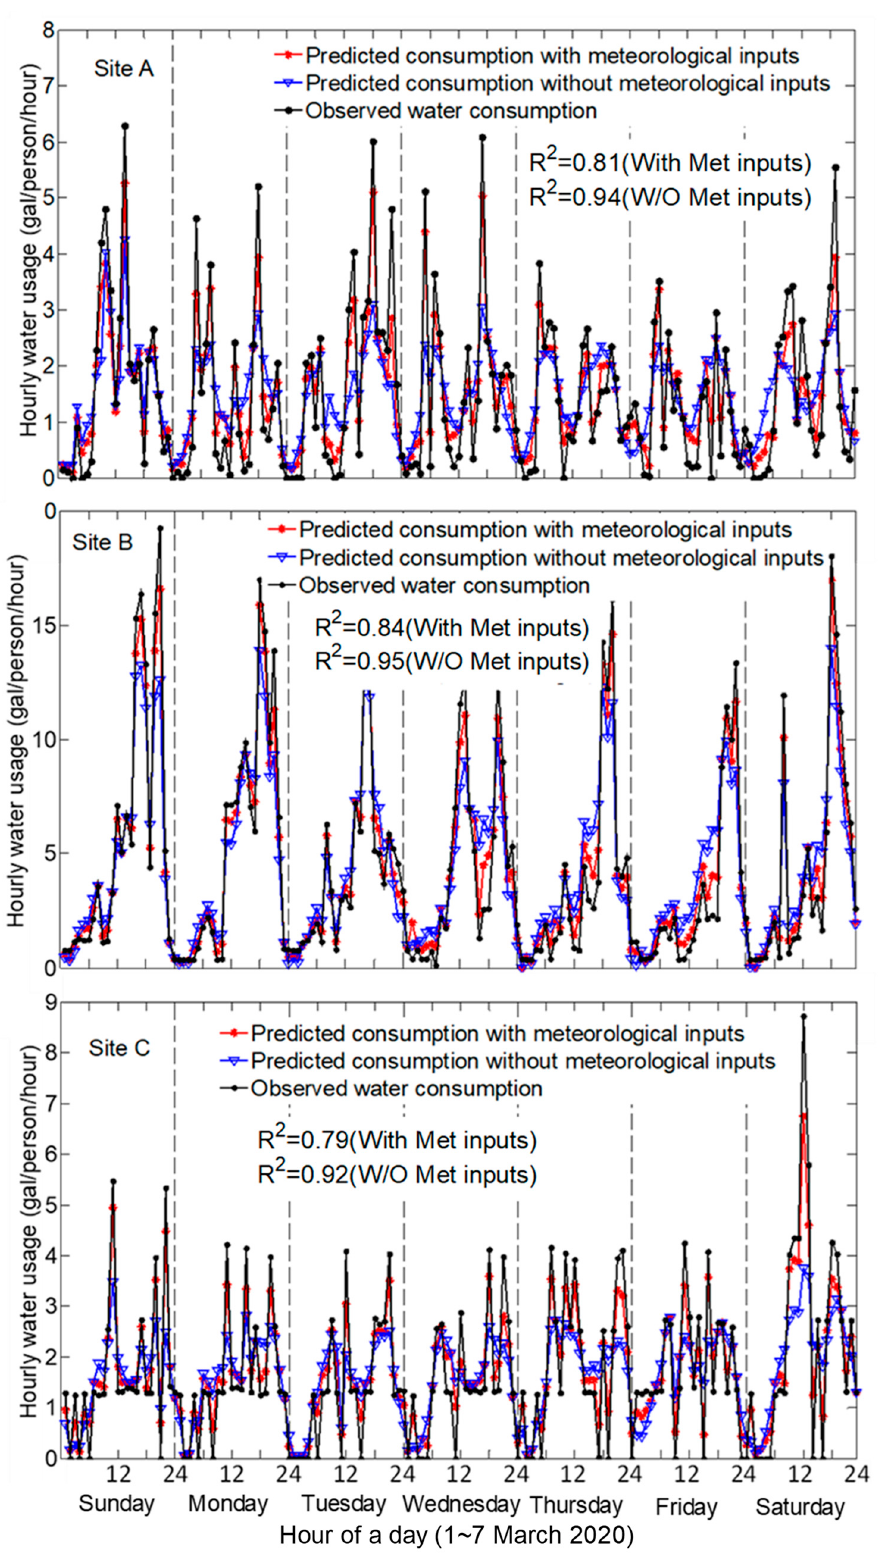
Figure 9. Illustration of validation of the hourly water usage model for a data trace during the first week of March 2020 (note: the indicated R 2 values are for the shown data trace). The ARMA model accounts for the month, week and day, hourly temperature, and total hourly rainfall input. Note: Training for hourly ARMA models for Sites A – C data were for the period of October 2015–December 2019 (Figure 7).